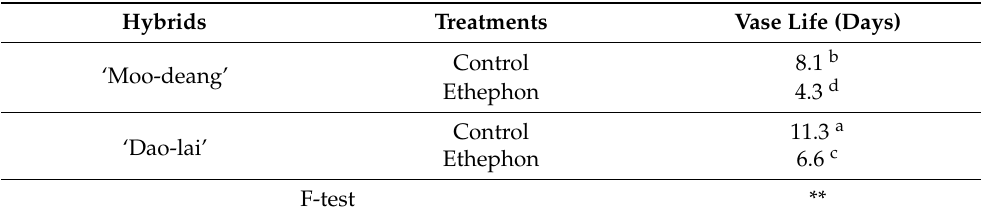
Table 2. Effect of ethephon on vase life duration of cut inflorescences of ‘Moo-deang’ and ‘Dao- lai’ Mokara orchid hybrids. Cut inflorescences were pulsed with either distilled water (control) or 10 µ L · L − 1 ethephon for 24 h, and then transferred to distilled water throughout the experimental period in the observation room. The results represent means of 8–10 replicates ± SE. Different letters represent significant differences at p ≤ 0.01, compared to distilled water according to DMRT